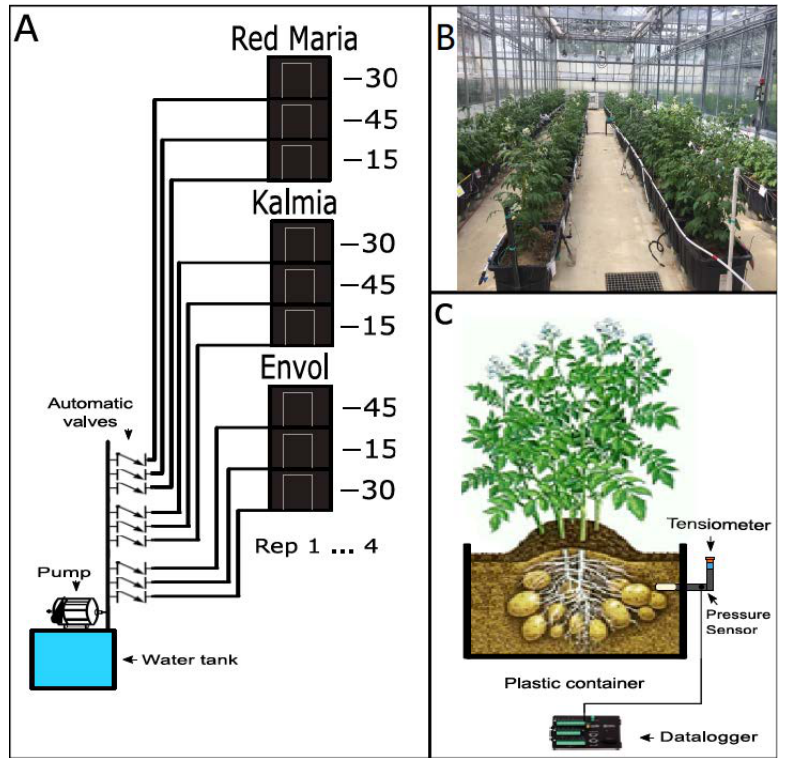
Figure 2. ( A ) Scheme of the experimental design in winter 2019 in the greenhouse, including three precision irrigation thresholds ( greenhouse experiment. ( C ) Scheme of the short side of an experimental unit.